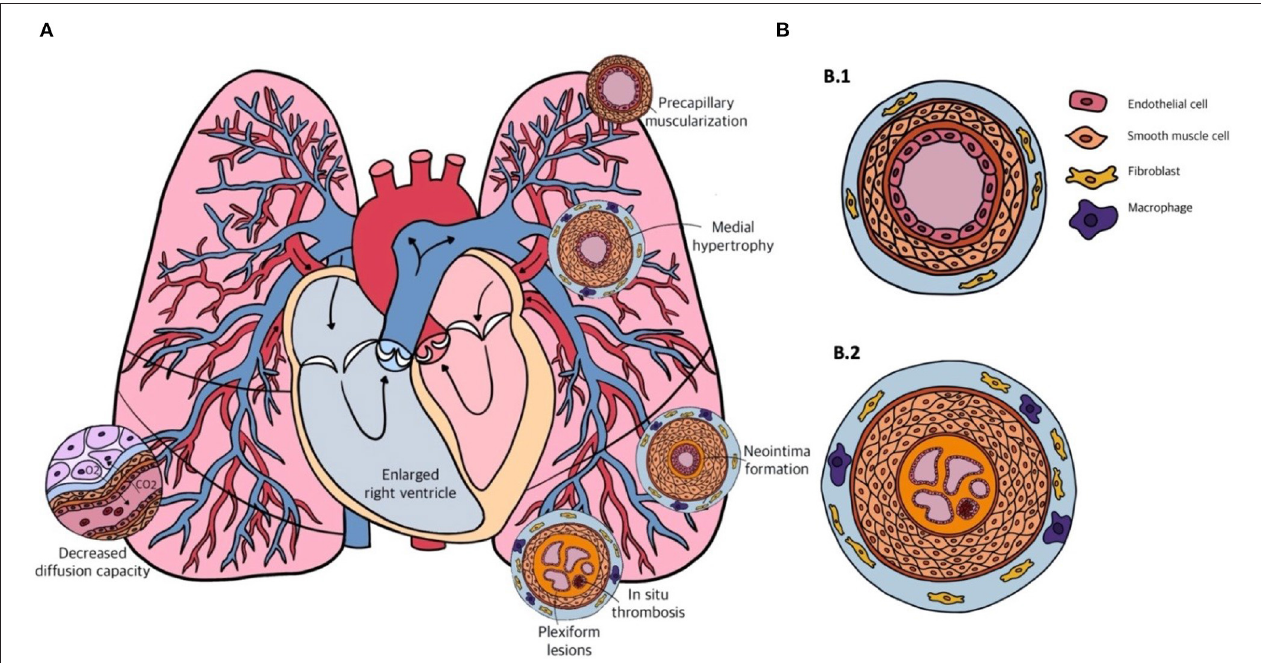
FIGURE 2 | (A) Schematic overview of the cardiopulmonary system in pulmonary arterial hypertension (PAH) and the different forms of vascular remodeling. (B) Transversal sections of the pulmonary arterial vasculature in a healthy person (B.1) and in a patient with end-stage PAH (B.2). Showing from inside to outside: multiple capillary channels typical for plexiform lesions, with in-situ thrombosis, intimal thickening, pulmonary artery smooth muscle cell (PASMC) proliferation in the medial layer, and infiltration of fibroblasts and macrophages in the adventitial